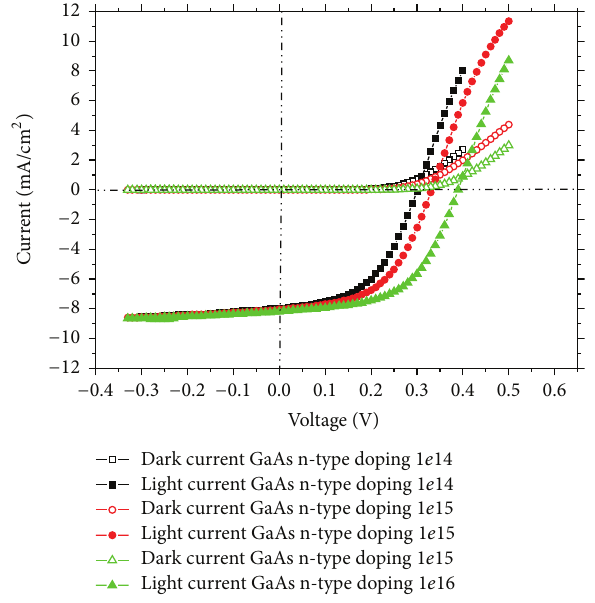
Figure 8: Current-voltage curves of graphene GaAs solar cells versus n-type doping concentration.